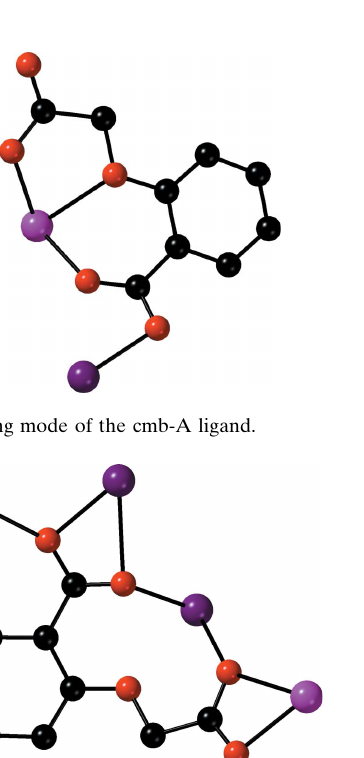
Figure 3 Exobidentate bridging mode of the cmb-B ligand.